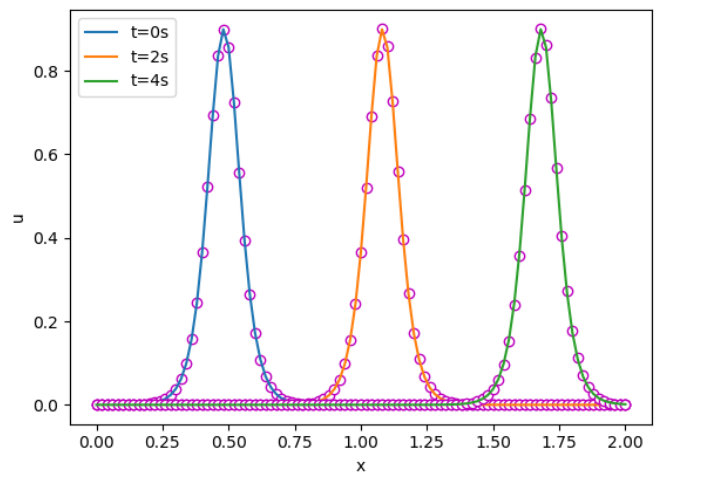
Figure 7. Approximate solution N = 100 for Example 4.